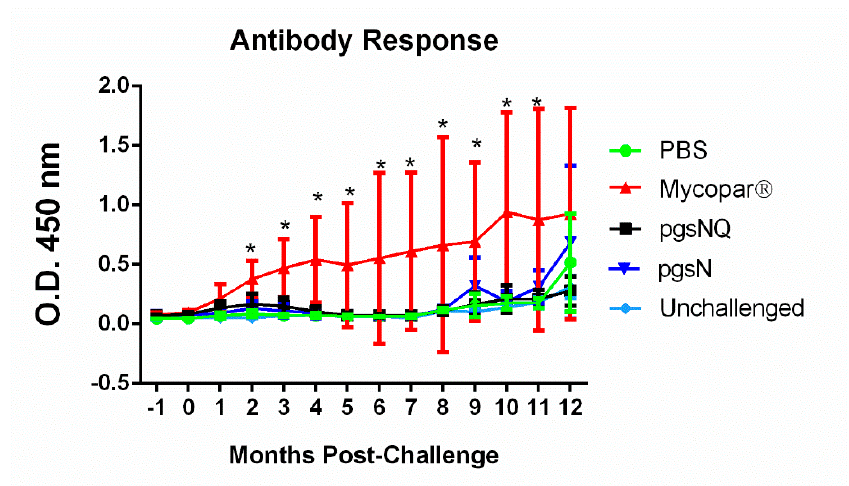
Figure 6. Humoral immunity in vaccinated and challenged calf groups. Commercial ELISA were used to analyze antibody levels in serum samples collected on monthly basis. Error bars represent the standard deviation of the average for each animal group for one month before challenge and 12 months post challenge; *, p < 0.05 compared to the PBS group.